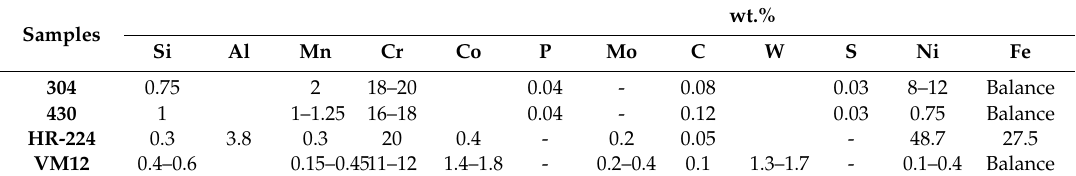
Table 2. Chemical composition of 304, 430 Stainless Steel, HR-224 alloy nickel, and ferritic steel VM12. Samples